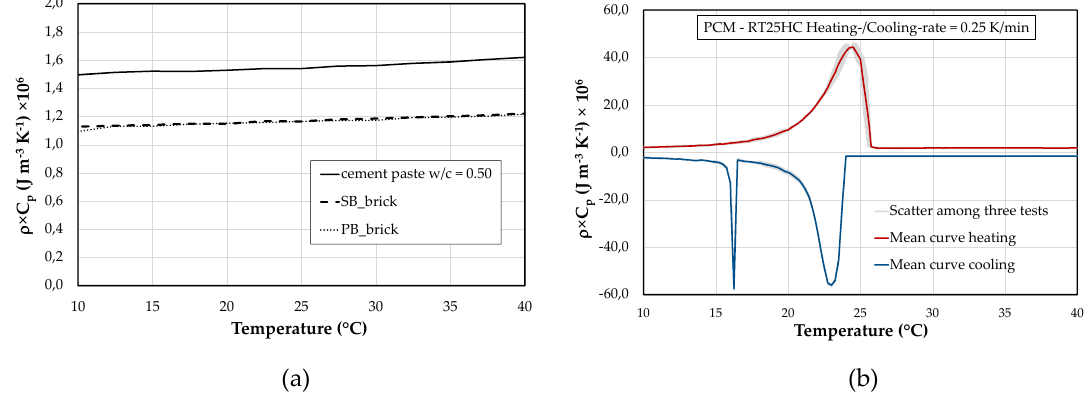
Figure 1. ρ × C p results of DSC measurements of ( a ) w / c = 0.50 cement pastes, SB and PB obtained Figure 1.  × C p results of DSC measurements of ( a ) w/c = 0.50 cement pastes, SB and PB obtained with with a heating / cooling rate of 10 K × min − 1 and ( b ) Para ffi n RT25HC with a heating / cooling rate of a heating/cooling rate of 10 K × min − 1 and ( b ) Paraffin RT25HC with a heating/cooling rate of 0.25 K × 0.25 K × min − 1 min − 1 .